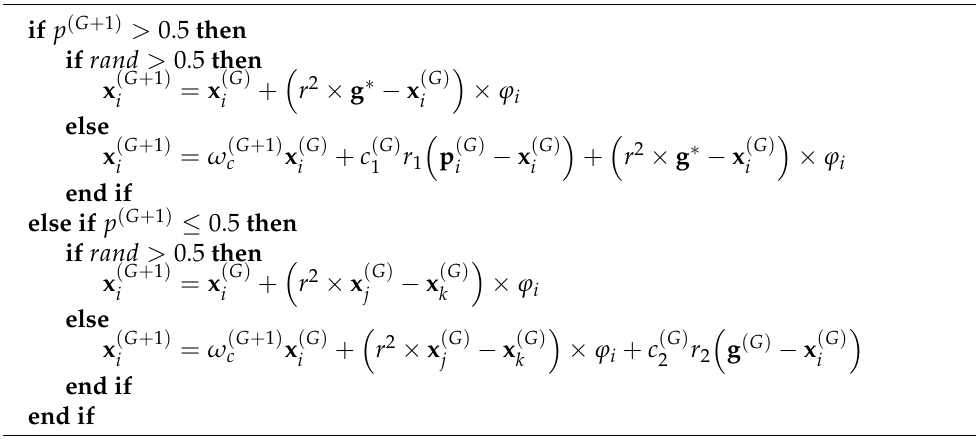
Algorithm 1 Position update of the i th butterfly of the proposed hybrid CAHBPSO